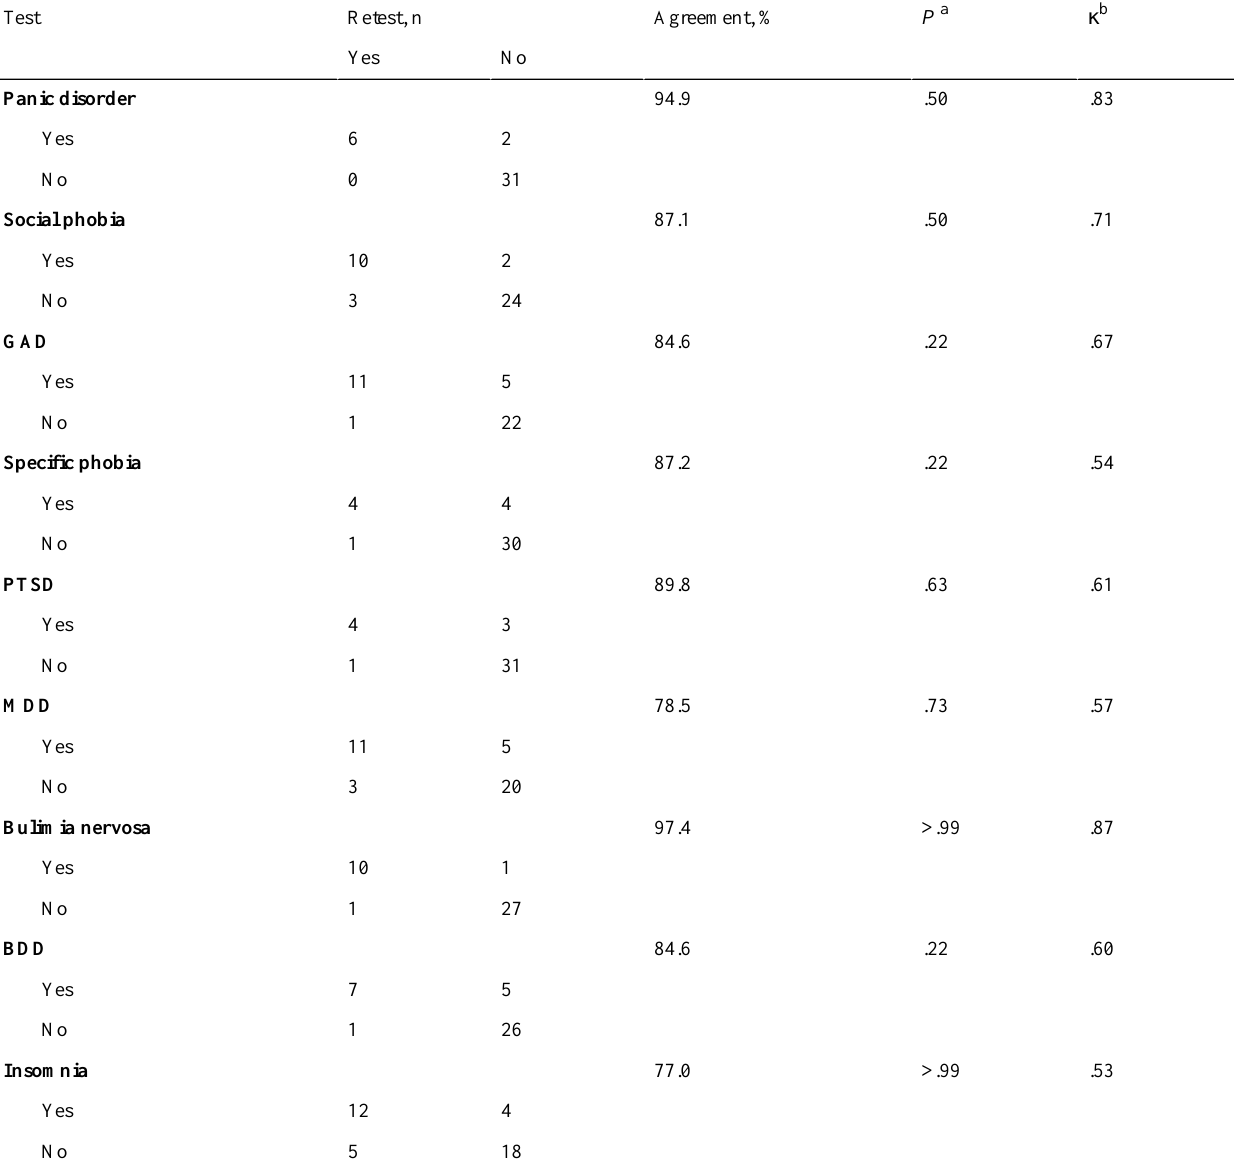
Table 4. Test-retest reliability of e-PASS clinical diagnoses